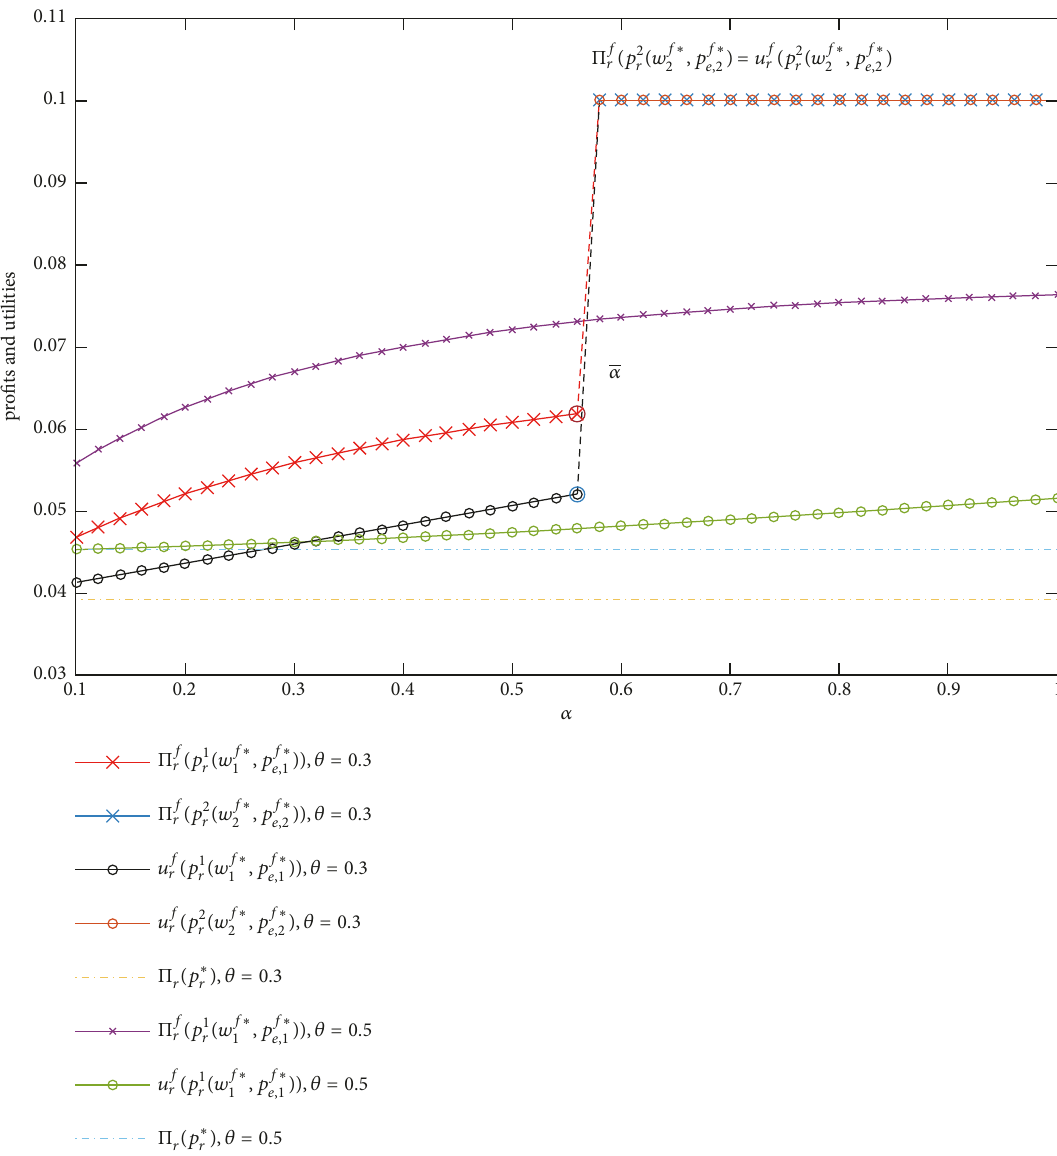
Figure 6: Impact of 𝜃 and 𝛼 on 𝜋 𝑓 𝑟 and 𝑢 𝑓 𝑟 for the two